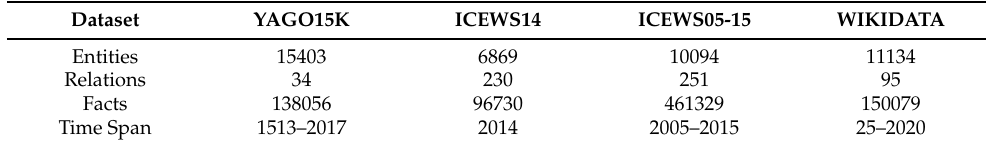
Table 2. Statistics of the